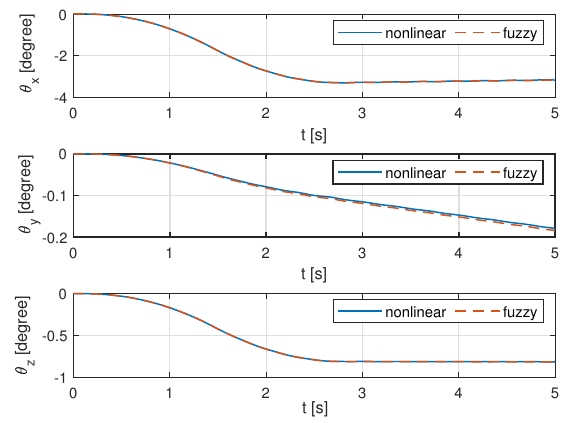
Figure 5. Angular position of the spacecraft.